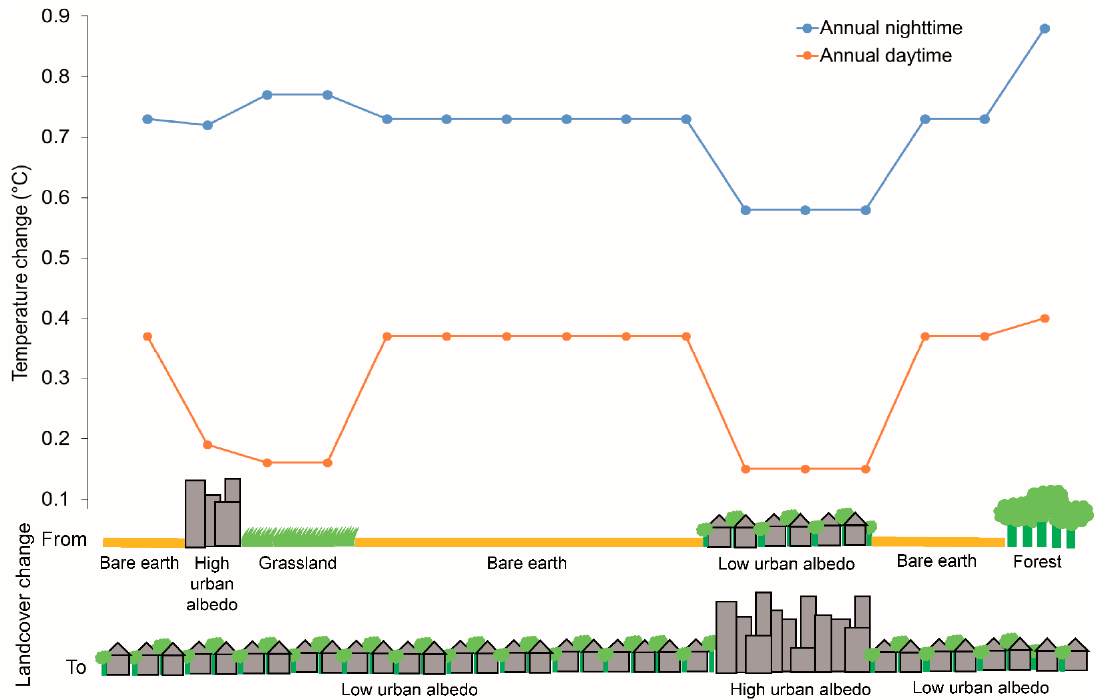
Figure 8. Land cover and average annual day and night time LST change between 2003 and 2013 for the cross section identified in Figure 1, excluding pixels of no change.